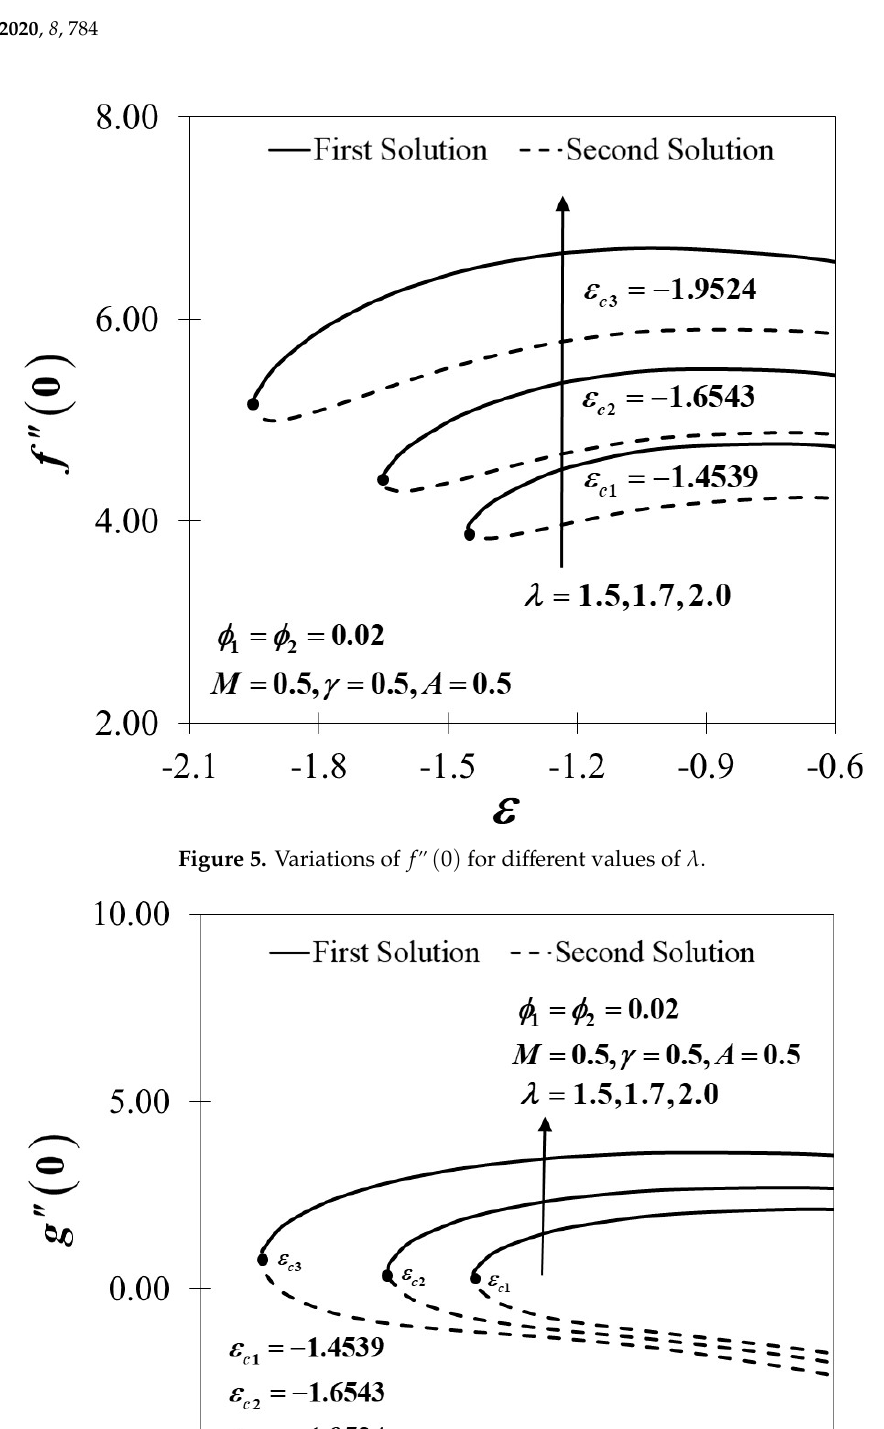
Figure 6. Variations of g (cid:48)(cid:48) ( 0 ) for di ff erent values of λ